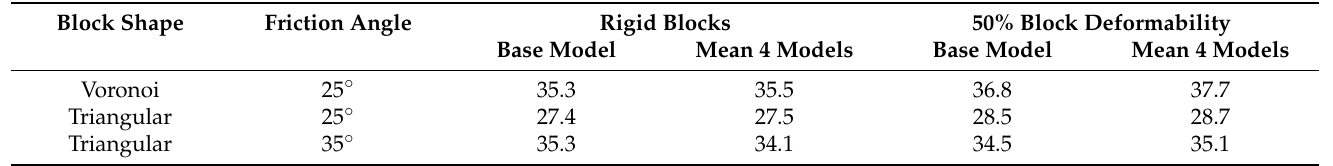
Table 5. Comparison of compressive strength (MPa) for Voronoi and triangular block models.